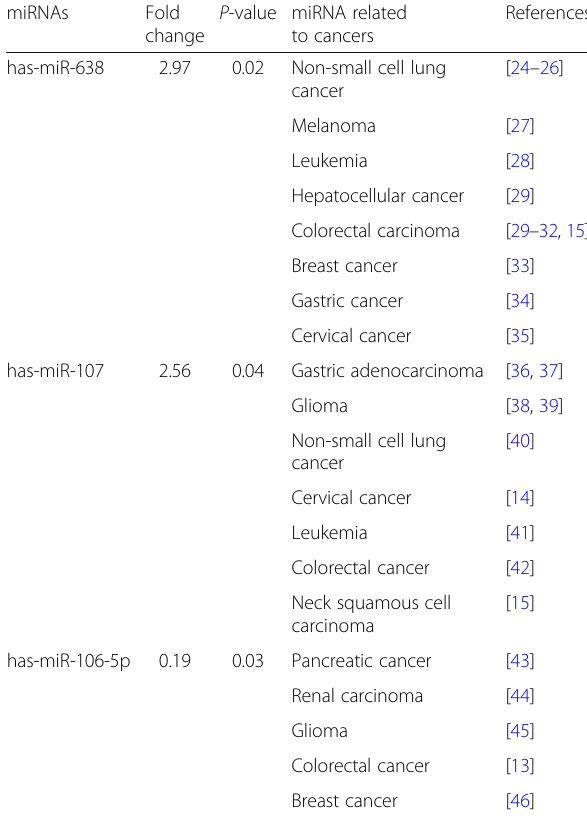
Table 2 Part differential miRNAs involving with cancers P -value miRNA related miRNAs Fold change to cancers